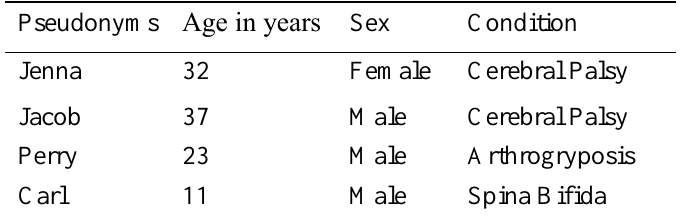
Table 1. Description of